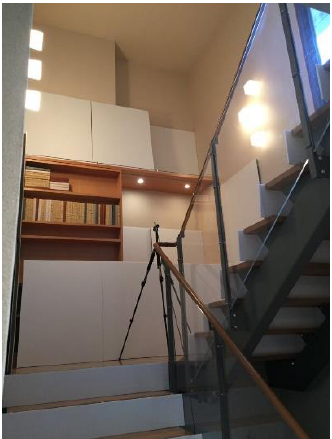
Figure 5. Sound absorption panel installation status in the riser. ( a ) Setup as seen from the first floor. ( b ) Setup as seen from the second floor.